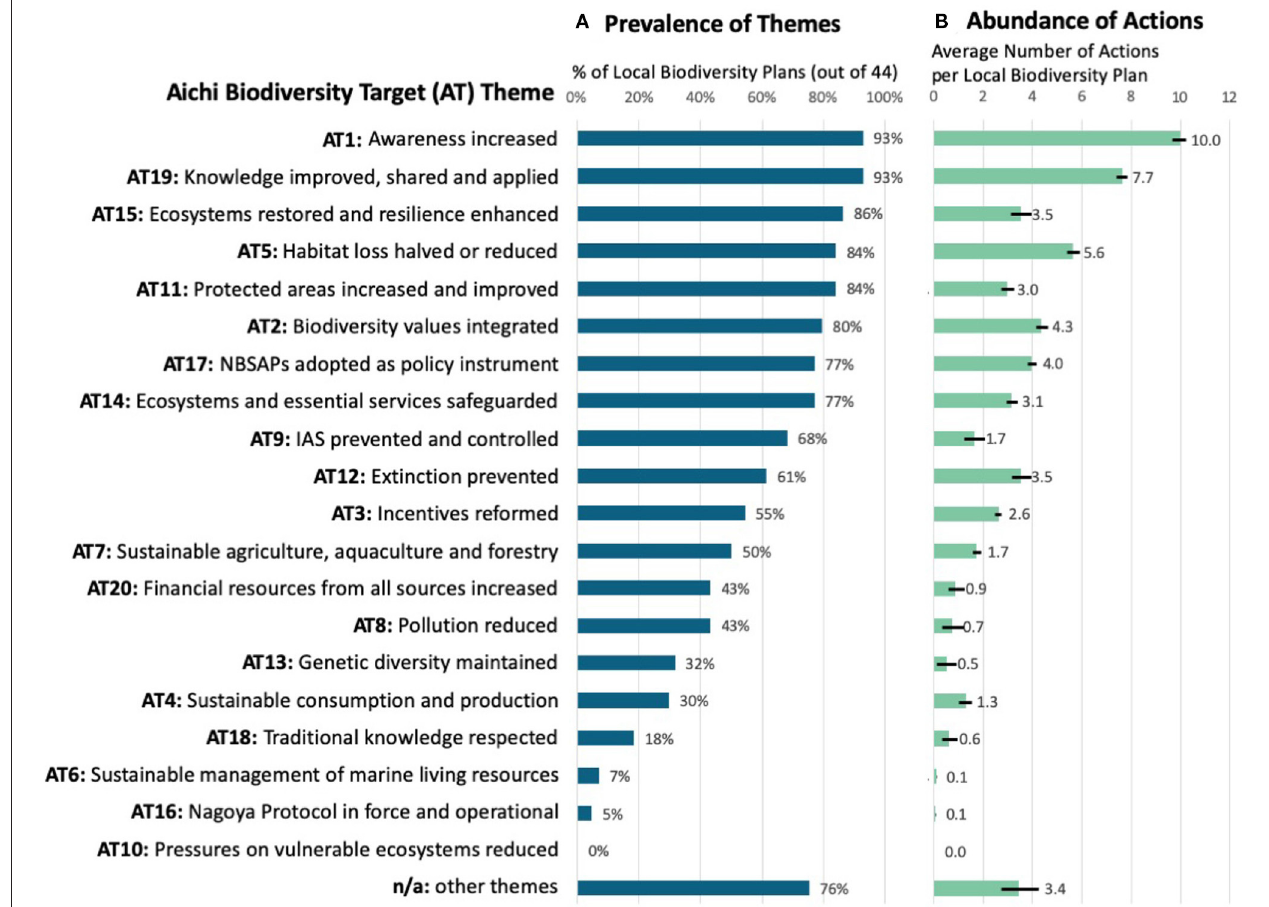
Frontiers in Conservation Science |